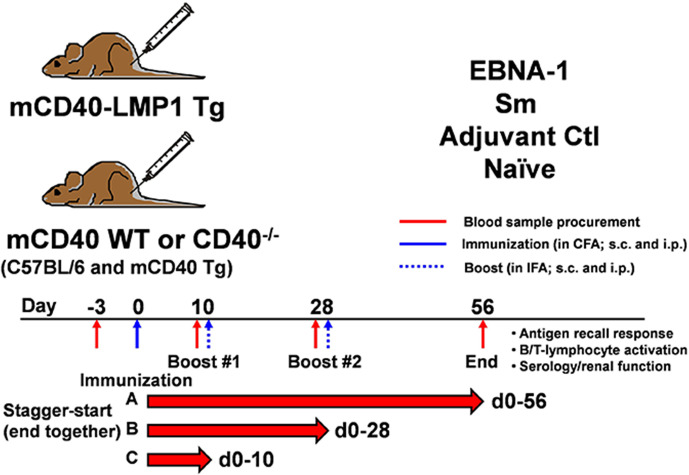
Immunization of mCD40-LMP1 Tg mice with EBNA-1, Sm, or controls to assess antigen-specific immune response and antigen cross-reactivity. As described in Materials and Methods, mCD40-LMP1 Tg, mCD40 WT (C57BL/6 and mCD40 Tg), and mCD40-/- mice remained naïve or were immunized with either saline (adjuvant only), EBNA-1, or Sm on Day 0 in CFA, then received boost injections (in IFA) on Days 10 and Day 28. Mice were euthanized on Day 56, spleen and lymph nodes removed, and cell cultures completed. Blood samples were procured for serum prior to initial immunization (Day -3), and on Days 10, 28, and 56 after initial immunization. Separate groups of EBNA-1 immunized mice completed Days 0–10 or Days 0–28 of the protocol. Each experimental group contained 6–8 mice across two separate experiments.